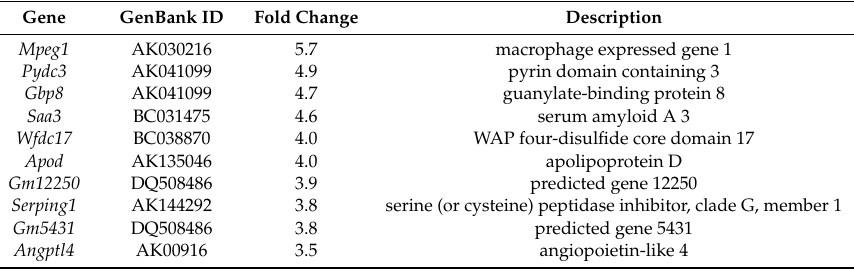
Figure 4. Gene expression profiles upon TLE3 knockdown in TM4 cells. ( a ) Volcano plot analysis between TLE3 knockdown (TLE3 KD) and control (CON). The red point in the plot represents up-regulation, and the blue point represents down-regulation of genes compared to those of CON. The vertical lines correspond to 1.5-fold up- and down-regulation with statistical significance. ( b ) Hierarchical clustering between CON and TLE3 KD. The yellow portion in the graph represents relatively down-regulated genes (1452 Down), and the blue portion represents relatively up-regulated genes (1597 Up) compared to those of the control. ( c ) Gene ontology enrichment and pathway analysis for differentially expressed genes. The score is shown as a fold enrichment value. Table 2. Top 10 up-regulated genes in TLE3 knockdown in TM4 cell.